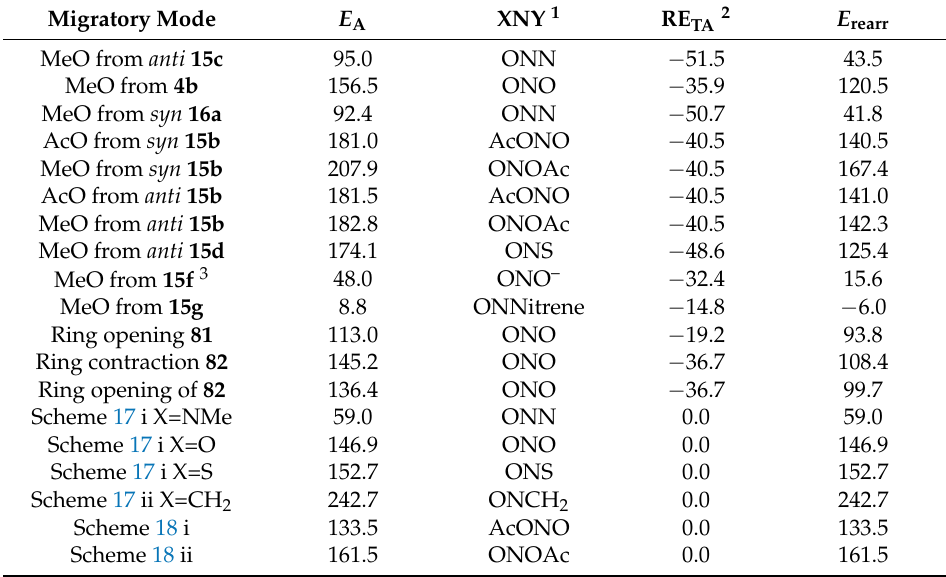
Table 8. B3LYP/6-31G(d) activation energies ( E ) for HERON reactions of model anomeric amides and tricyclic anomeric amides; all energies ( E rearr values in kJ mol −